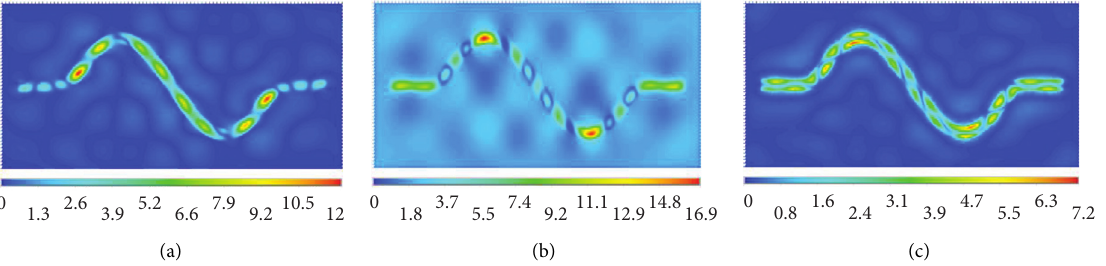
� 300m/s, f � 2.0Hz, H � 100 m, and NR � 2). Top view displacement cloud view (a) u s